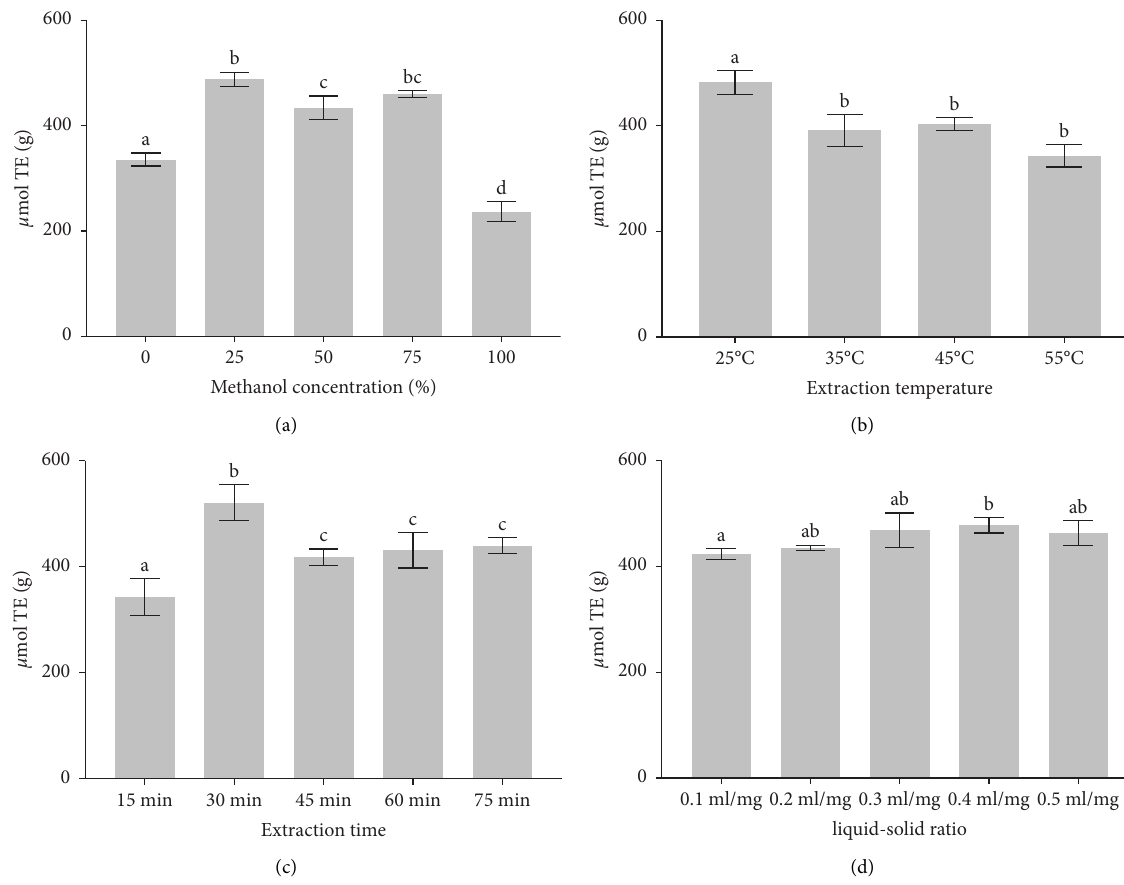
Figure 1: Infuence of methanol concentration (a), extraction temperature (b), extraction time (c), and liquid-solid ratio (d) on the yields of antioxidants from